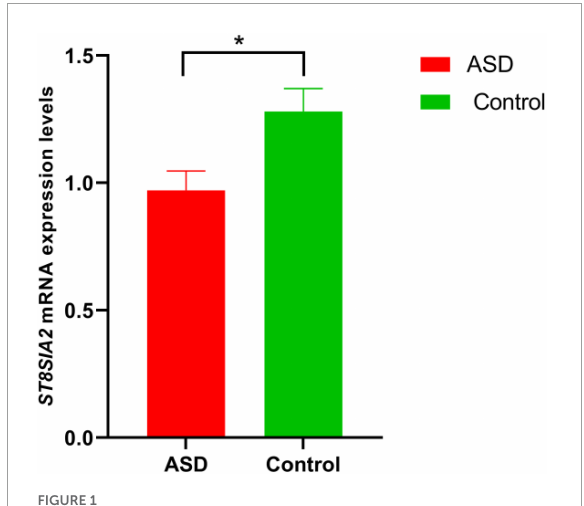
FIGURE1 ST8 alpha-N-acetyl-neuraminide alpha-2,8-sialyltransferase 2 ( ST8SIA2) mRNA levels in the autism spectrum disorder (ASD) and control groups ( N ASD = 69, N control = 76). Data represented as means ± SEM. * p < 0.05 from the two dependent t